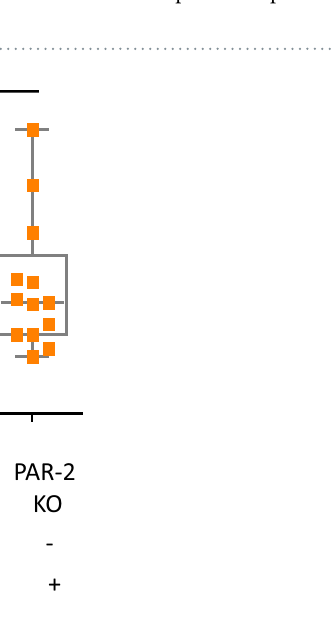
Figure 3. DAMGO induces itch in PAR-2 deficient mice. Scratching bouts evoked by intradermal injections of either PBS or DAMGO (200 µ M) in WT (PBS; n = 12, DAMGO; n = 16) and PAR-2-deficient mice (PBS; n = 7, DAMGO; n = 13). Results are represented as Whisker-dot plot (Min-Mean-Max) and each symbol represents an individual mouse. Statistical analysis were performed using Kruskall-Wallis followed by post-hoc Dunn’s test ( *** p < 0.001 WT + DAMGO versus WT + PBS and *** p < 0.001 represents PAR-2 KO + PBS versus PAR-2 KO +